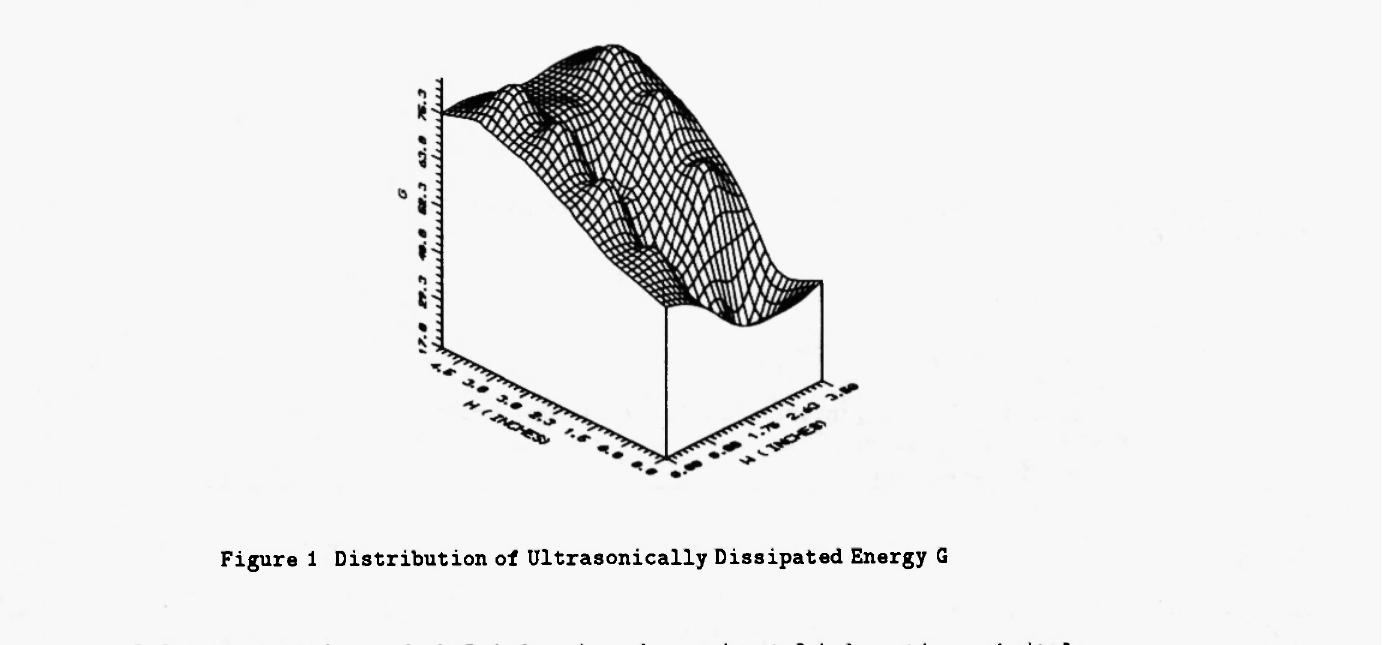
Figure 1 Distribution of Ultrasonically Dissipated Energy